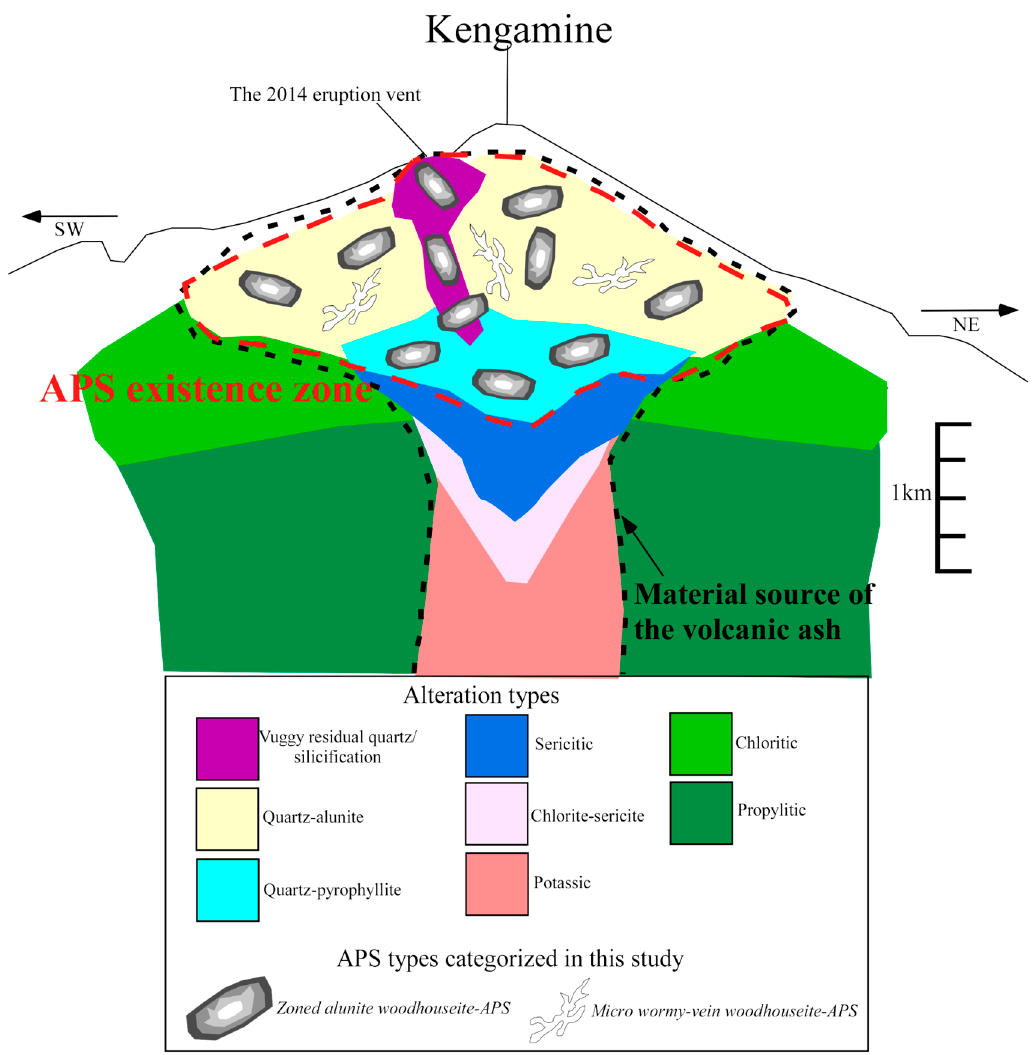
Figure 7. APS existence zone in the material source model (alteration column) of the volcanic ash from the 2014 Ontake eruption. This figure was created and modified from [29,50]. The APS existence zone surrounded by the dashed red line was based on petrography and mineralogy of the individual volcanic ash ( Figure 5; Figure 6). The black dotted area is whole material source of the volcanic ash (maximum depth ~2 km) estimated by Minami et al. 2016 [29].